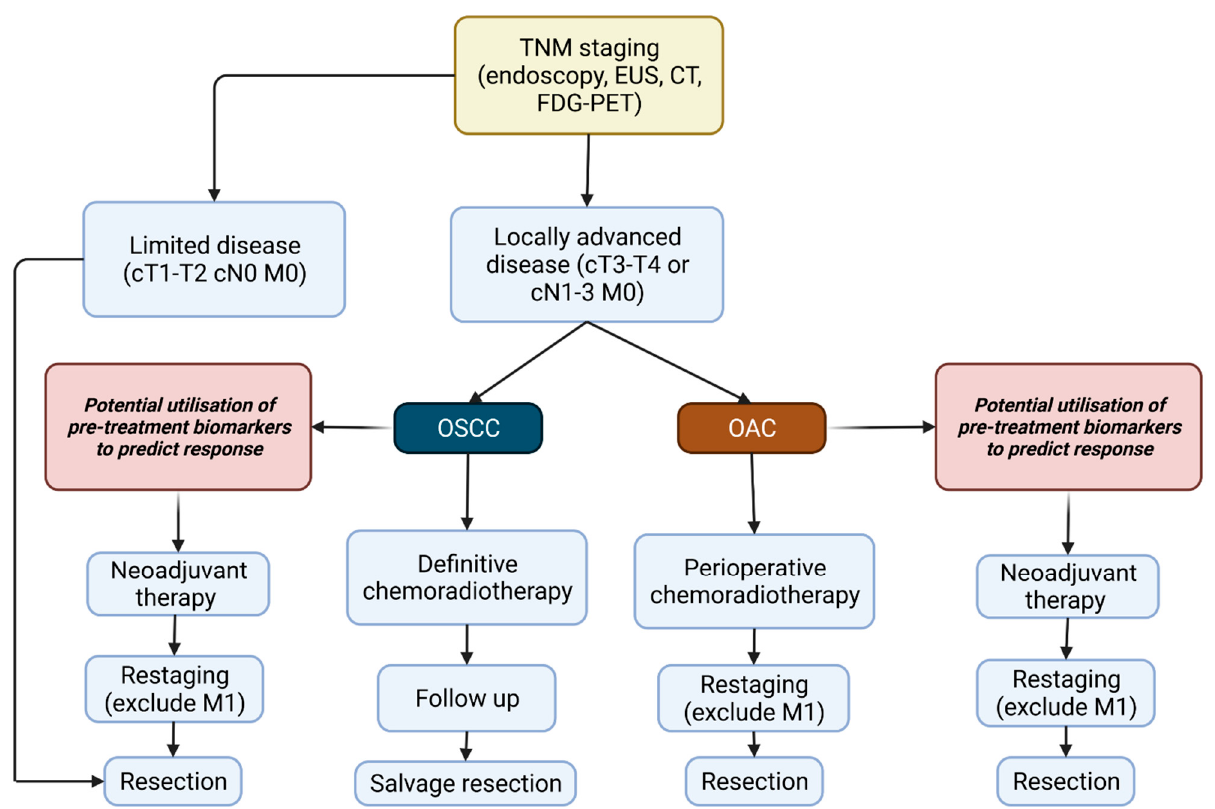
Figure 1. Current treatment strategies for oesophageal cancer as outlined by the European Society of Medical Oncology. TNM staging: T describes tumour size and any cancer spread into adjacent tissue; N describes cancer spread to adjacent lymph nodes; M describes metastasis (Adapted from “Oesophageal Cancer: ESMO clinical Practice Guidelines” (2016) [27]. Created with BioRender.com, accessed on 17 February 2022).